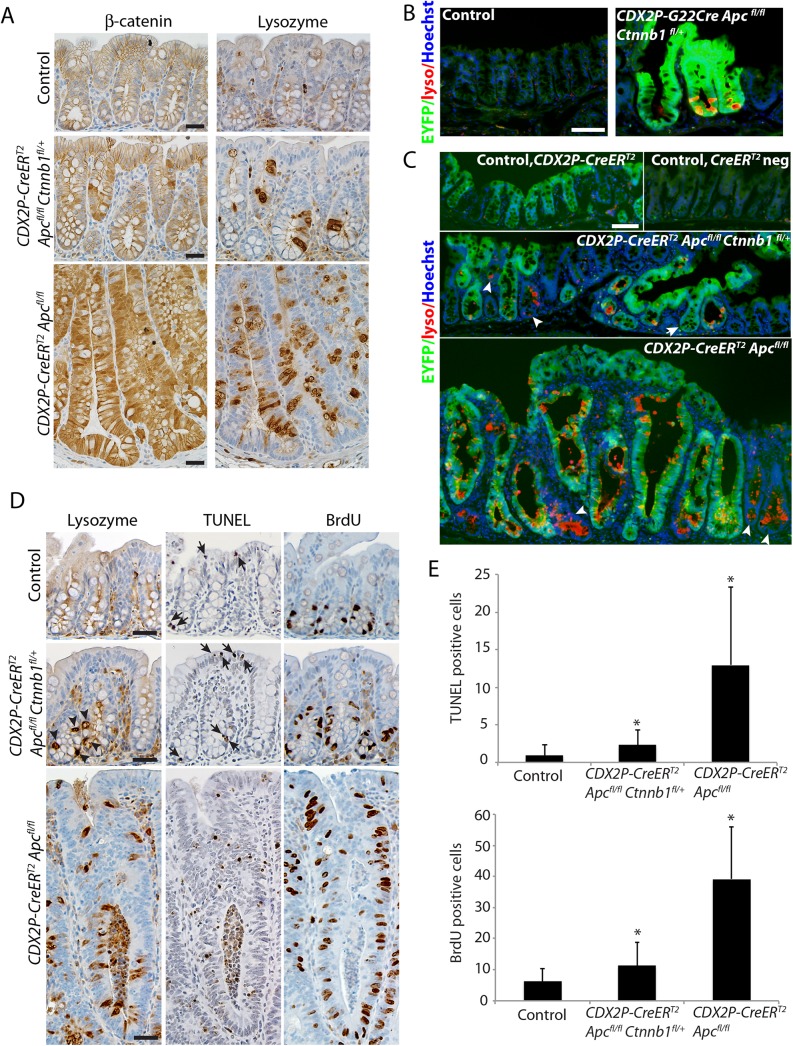
Inactivation of a Ctnnb1 allele in mouse colon epithelium reduces apoptosis and hyperproliferation induced by bi-allelic Apc inactivation, and also reduces, but does not abrogate, the aberrant cell differentiation associated with Apc inactivation.(A) Representative immunohistochemical staining for β-catenin (left panels) and lysozyme (right panels) in a CDX2P-CreER
T2
Apc
fl/fl
Ctnnb1
fl/+ mouse (middle row) or a Cdx2P-CreER
T2
Apc
fl/fl mouse (bottom row) 20 days following three daily doses of TAM. Immunohistochemical staining is also shown for normal control colon mucosa from a Cre negative control littermate mouse (top row). Scale bars, 20 μm. (B and C) EYFP expression activated in targeted colon crypts by Cre-mediated recombination was imaged along with Immunofluorescence staining for lysozyme (lyso; red) in proximal colon tissues that were counter-stained with Hoechst 33342 for detection of nuclei. A 6-month old G22Cre Apc
fl/fl
Ctnnb1
fl/+
EYFP
fl/+ mouse and a Cre negative control littermate are shown in panel B. Colon tissues from a CDX2P-CreER
T2
Apc
fl/fl
Ctnnb1
fl/+
EYFP
fl/+ mouse (panel C, middle) or a CDX2P-CreER
T2
Apc
fl/fl
EYFP
fl/+ mouse (panel C, bottom) were analyzed 38 days after the third of three daily doses of TAM. Colon tissues from a CDX2P-CreER
T2
EYFP
fl/+ mouse (panel C, top left) and a Cre-negative EYFP reporter mouse (panel C, top right) served as controls. Arrowheads indicate the EYFP-negative crypts that expressed the Paneth cell maker, lysozyme. An arrow in the middle panel indicates a crypt showing EYFP expression but no lysozyme staining. Scale bars, 50 μm. (D) TUNEL assay (middle column panels) and immunohistochemical staining for lysozyme (left column panels) and BrdU (right column panels) in proximal colon tissues of a CDX2P-CreER
T2
Apc
fl/fl
Ctnnb1
fl/+ mouse (middle row) or a Cdx2P-CreER
T2
Apc
fl/fl mouse (bottom row) 20 days after three daily doses of TAM. The normal colon mucosa from a cre negative mouse served as control (top row). Arrows indicate apoptotic cells in tissues from a CDX2P-CreER
T2
Apc
fl/fl
Ctnnb1
fl/+ mouse and the control mouse; arrowheads indicate the lysozyme-positive cells in tissues from a CDX2P-CreER
T2
Apc
fl/fl
Ctnnb1
fl/+ mouse. Scale bars, 25 μm. (E) Apoptotic cells per crypt in proximal colon, based on the TUNEL assay, were quantified (panel E, top; n = 3 and >100 crypts counted; *P < .001 compared to the control mouse). Proliferating cells per crypt, as assessed by BrdU incorporation, was quantified (panel E, bottom; n = 3 and >110 crypts counted; *P < .001 compared to the control mouse).